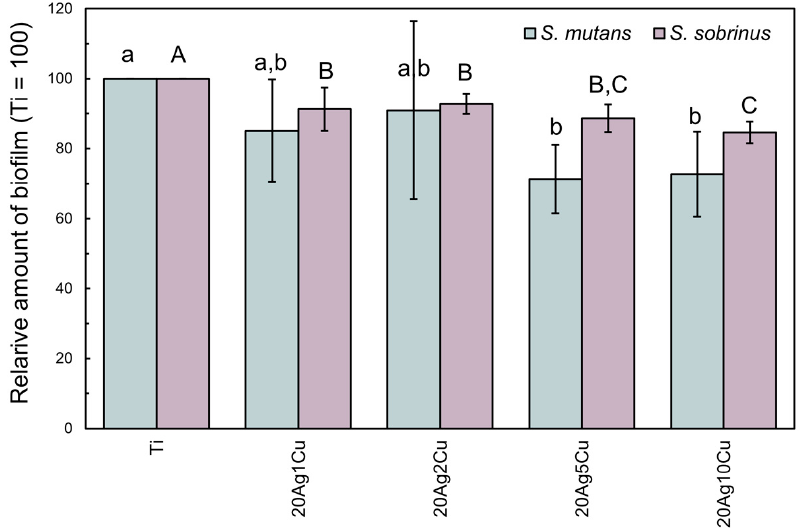
Figure 9. The relative amount of biofilm scraped from the surfaces of each specimen. Identical letters indicate a statistically insignificant difference ( p > 0.05).